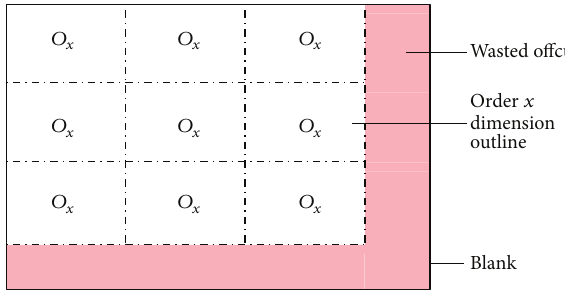
Figure 2: The partitioning of a blank with dimensions of an order 𝑥